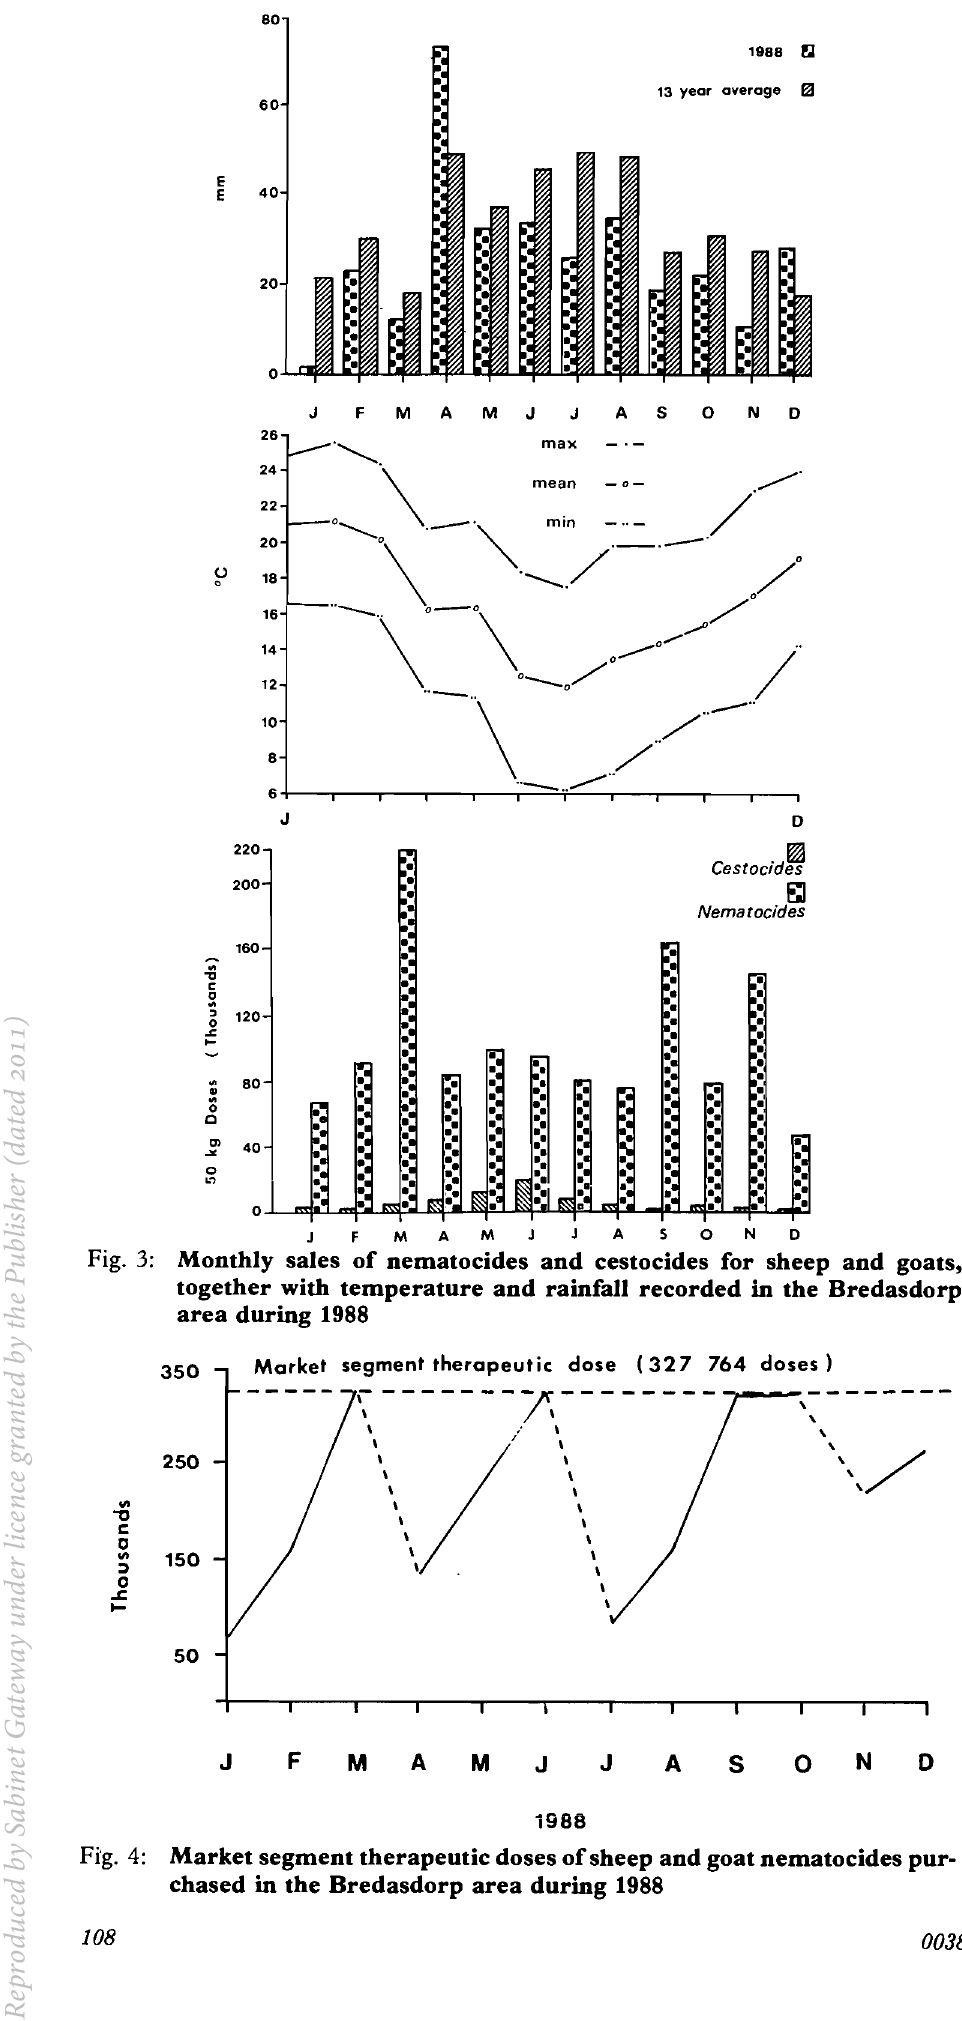
Market segment therapeutic doses of sheep and goat nematocides pur· chased in the Bredasdorp area during 1988